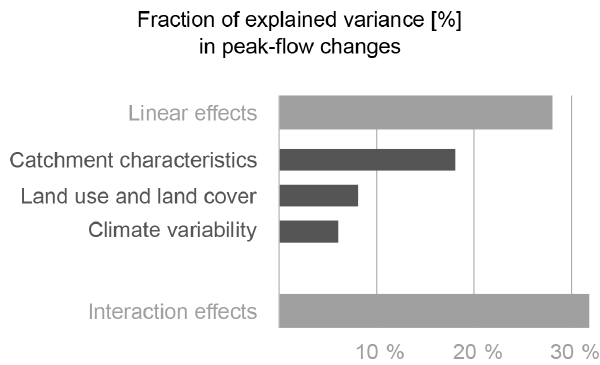
Figure 4. Linear effects and interaction effects between catchment characteristics, climate variability and land cover changes play an equal role in explaining streamflow